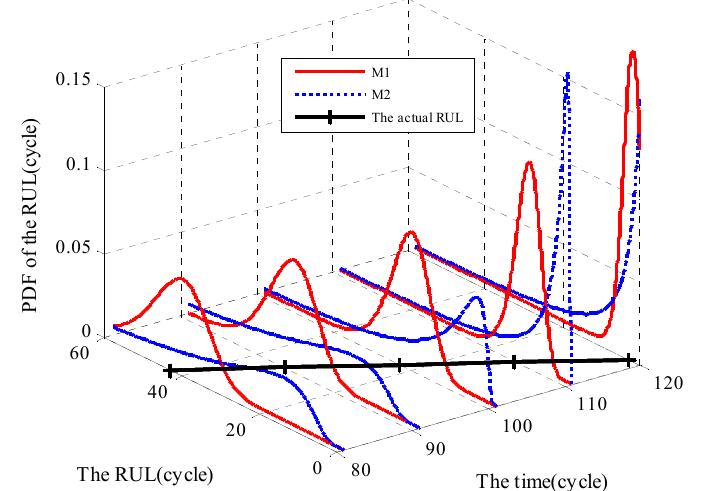
Figure 8. The estimated PDF of the RUL by M1 and M2.